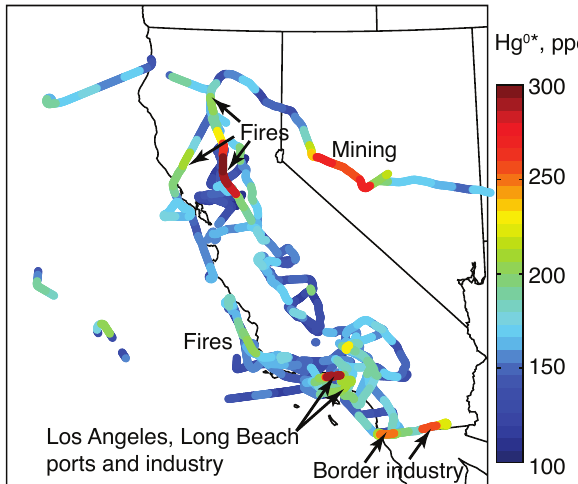
Fig. 12. Mercury distribution in the boundary layer ( < 2kma.g.l.) during ARCTAS flights over California and Nevada (June 2008). Sources are identified through correlations with other species (CO, O 3 , CH 3 CN,